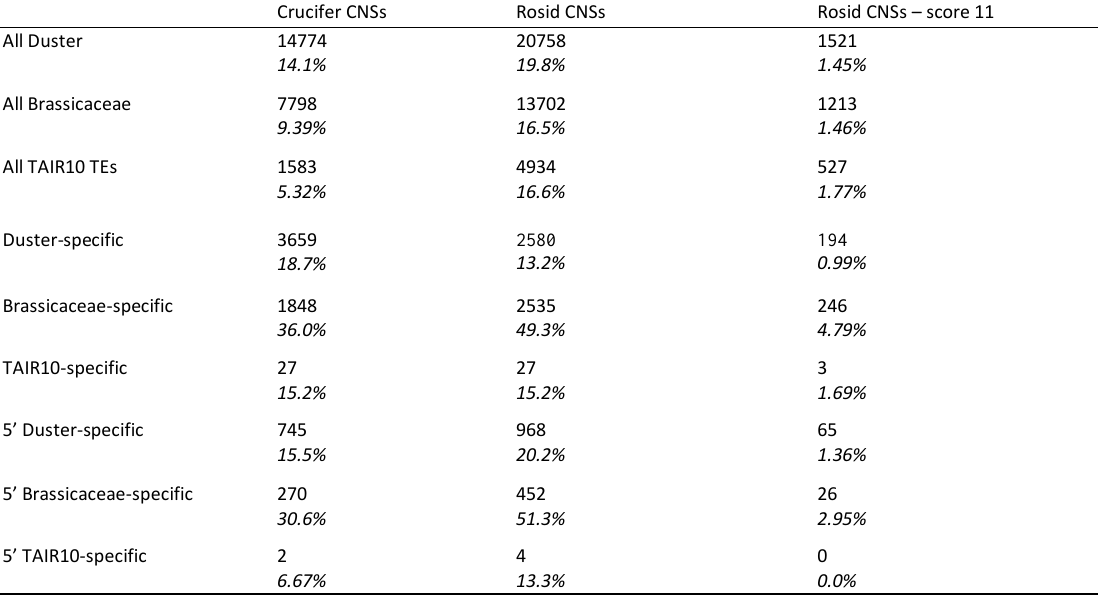
Table 2: Number of CNSs and percentage overlap with TE